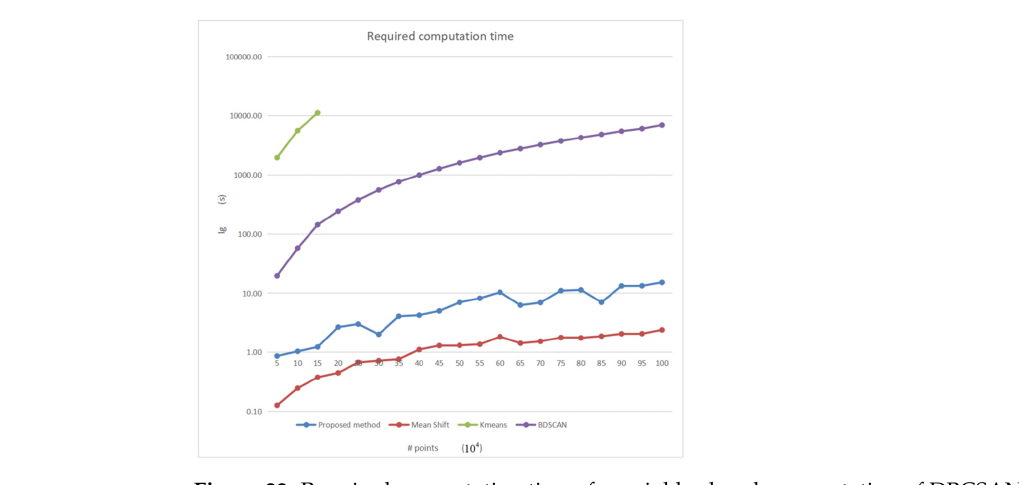
Figure 22. Required computation times for neighborhood segmentation of DBCSAN, kmeans, mean shift, and the proposed method.